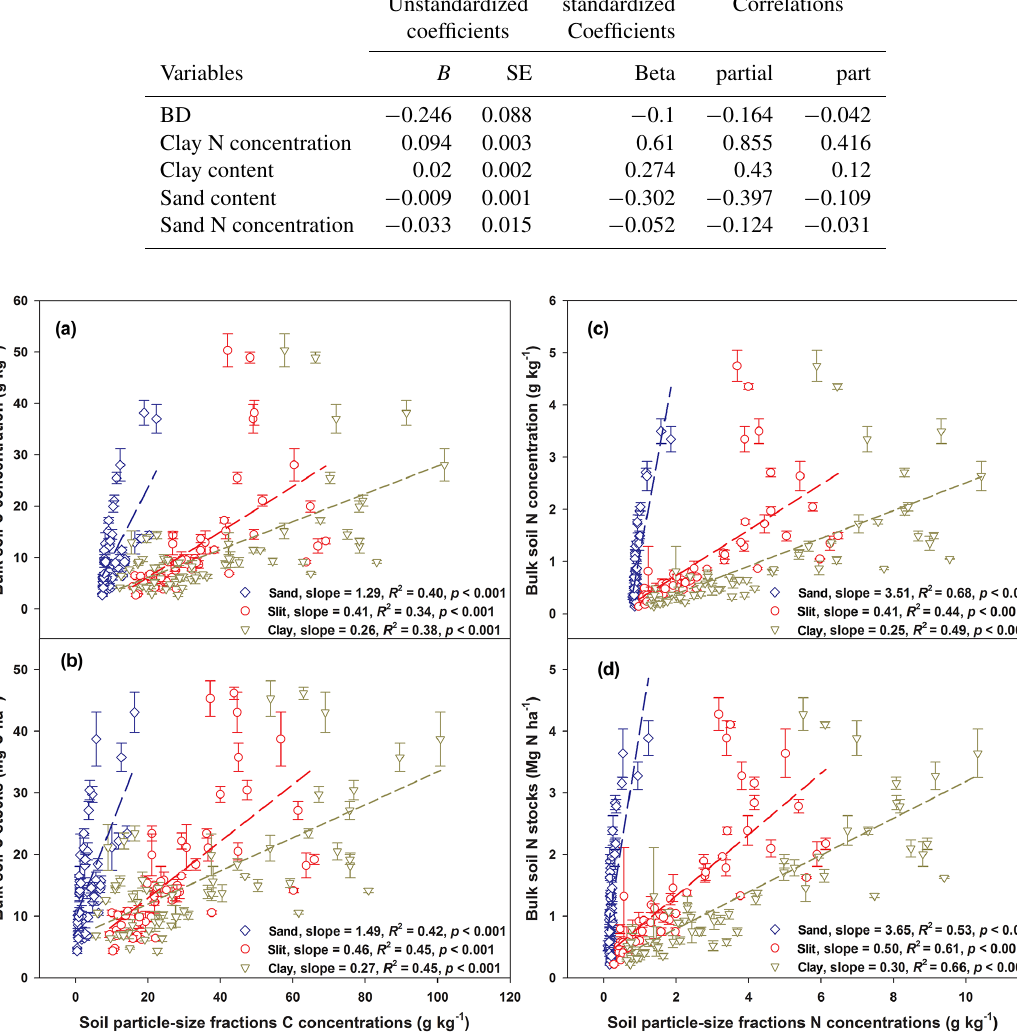
Figure 5. The concentrations and stocks of C (a, b) and N (c, d) in bulk soils were positively correlated with their concentrations in sand, silt, and clay. Data are presented as mean ± 1SE ( n =